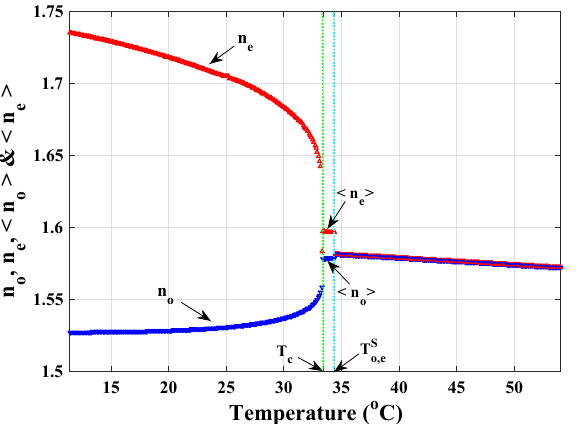
Figure 12. Variations for n o and n e in the bulk of LC during the nematic phase, for < n o > and < n e > resulting from their regular development in the surface-aligned nematic films, and lastly for the bulk of the LC during the isotropic phase. The average optical birefringence of anisotropic LC, ¯ (cid:31) n , occurs in the temperature range between the first-order transitions of the LC bulk in the nematic phase and the LC bulk in the isotropic phase, T C < T < T S o , e , after the development of the ordered surface